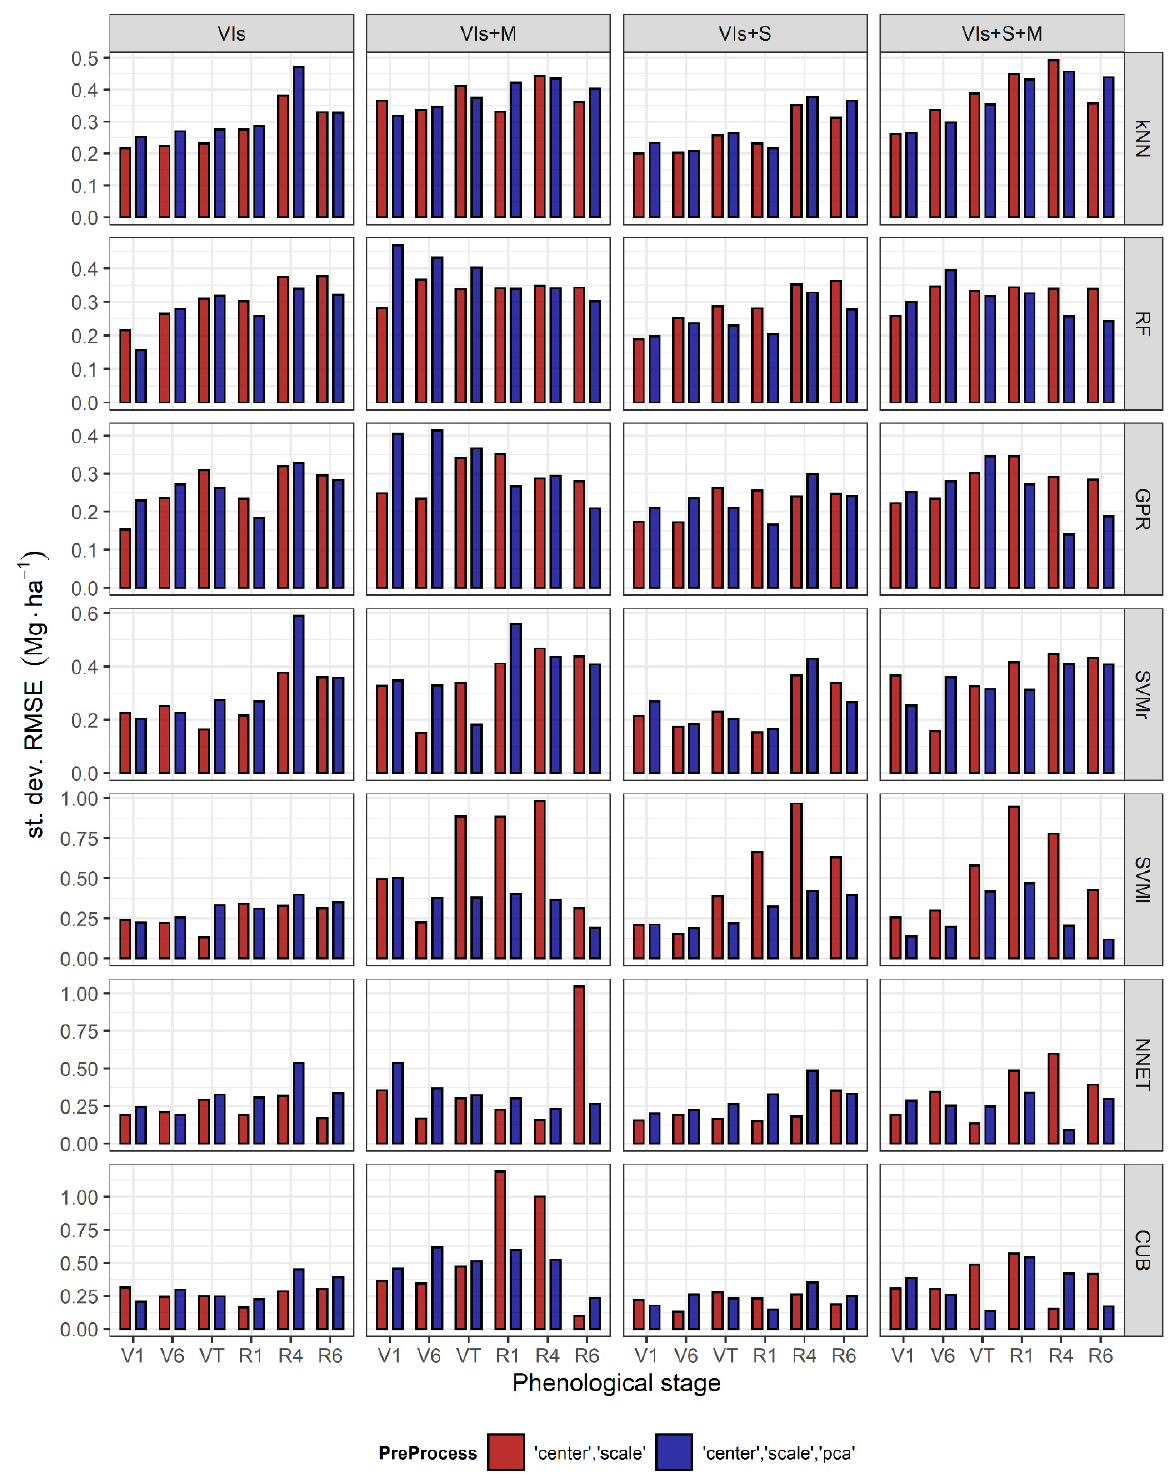
Figure 6. Summary of the standard deviation outer loop cross-validation (nested cross-validation) after the application of PCA.